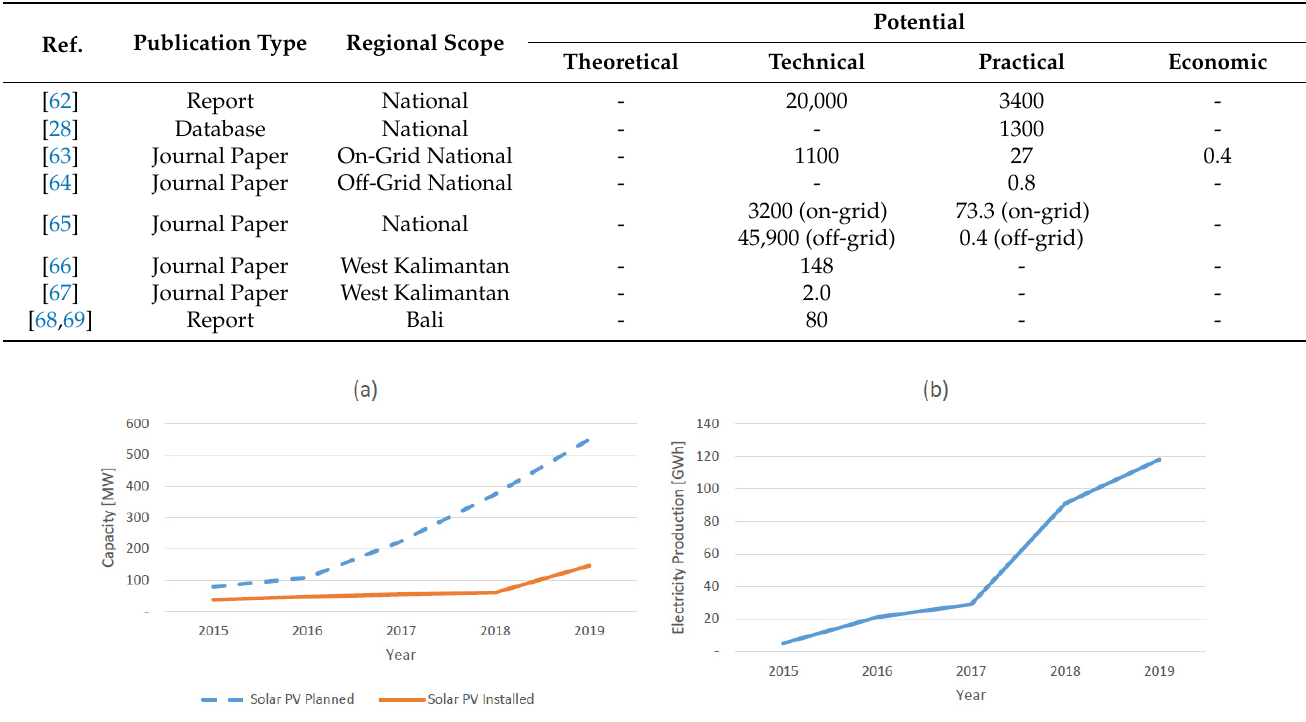
Figure 5. ( a ) Planned vs. installed solar PV capacity. ( b ) Electricity production from solar PV [2,5].